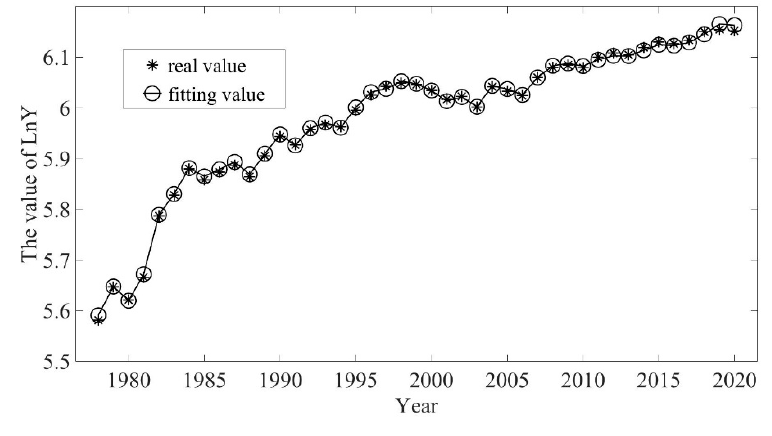
Figure 1. The fitting results of the model.